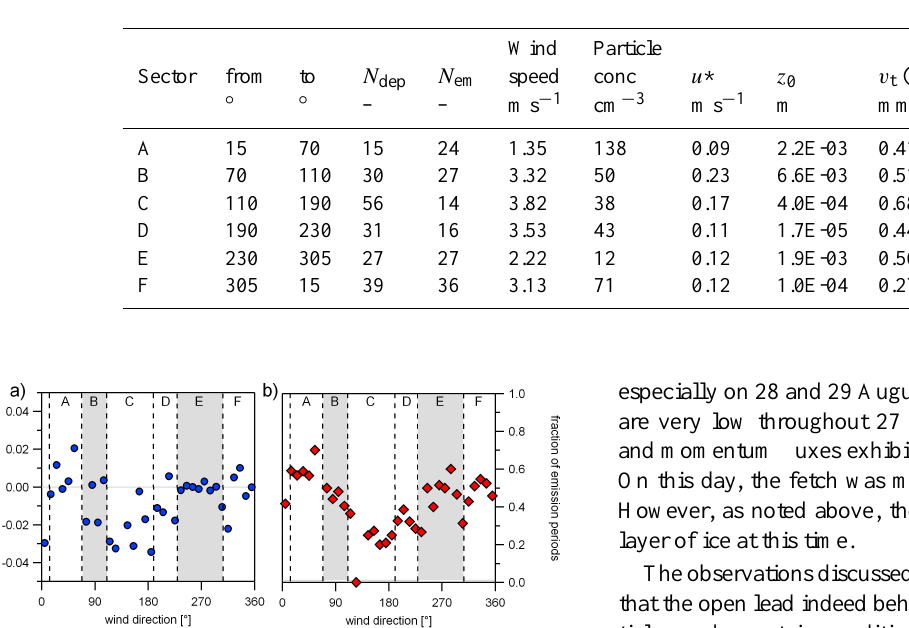
Table 1. Median values of wind speed, particle number concentration, friction velocity u ∗ , roughness length z 0 , and transfer velocities v t , respectively, for six wind sectors with different surface characteristics (L: lead, IR: ice ridge, I: ice floe). N dep is the number of deposition dominated 30 min periods in each sector, N em of emission dominated periods.